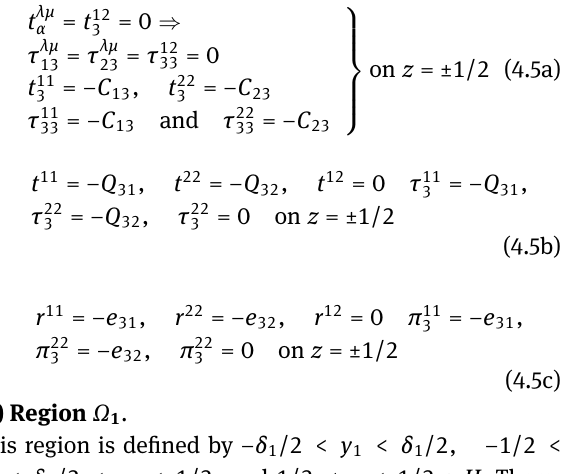
Figure 6: Thin magnetoelectric wafer-reinforced plate and its peri- odicity cell.